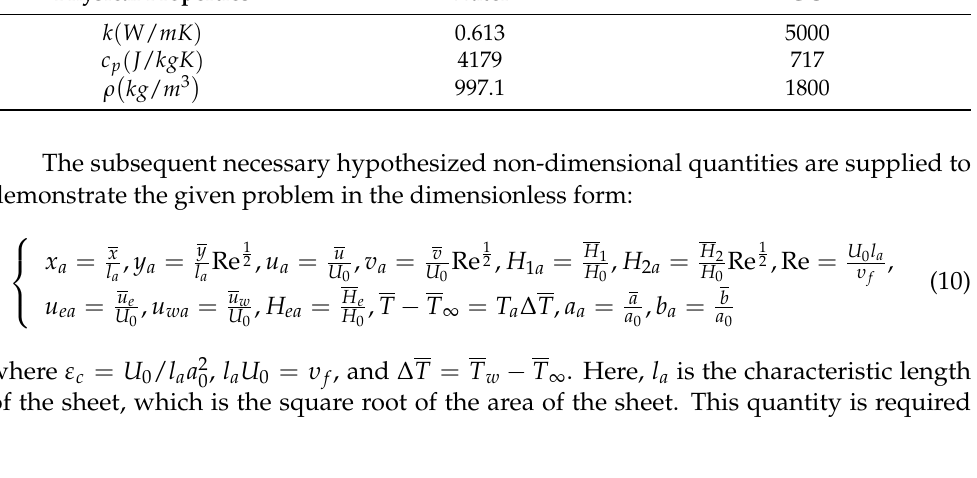
Table 1. Thermophysical data of the base fluid and GO nanoparticles [40]. Physical